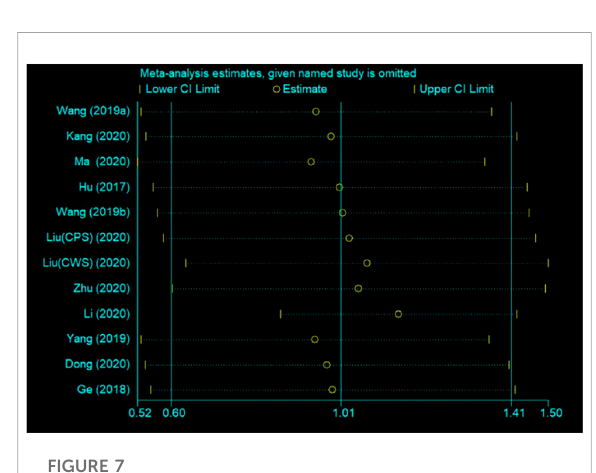
FIGURE 7 Sensitivity analysis of FC versus LBL in theoretical test